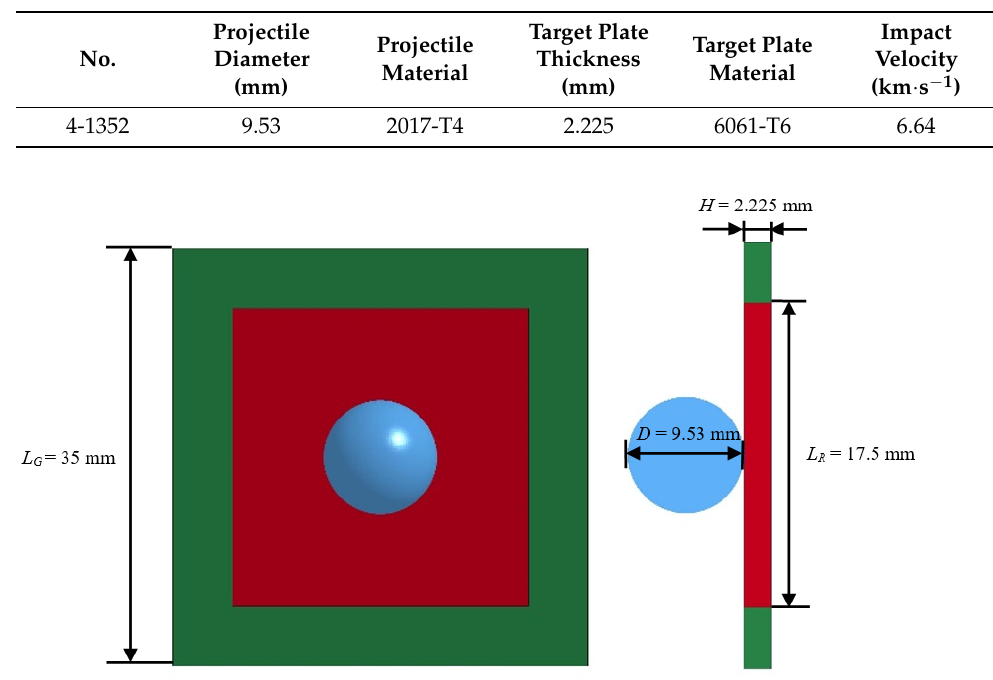
Figure 5. (4-1352 test) simulation and calculation